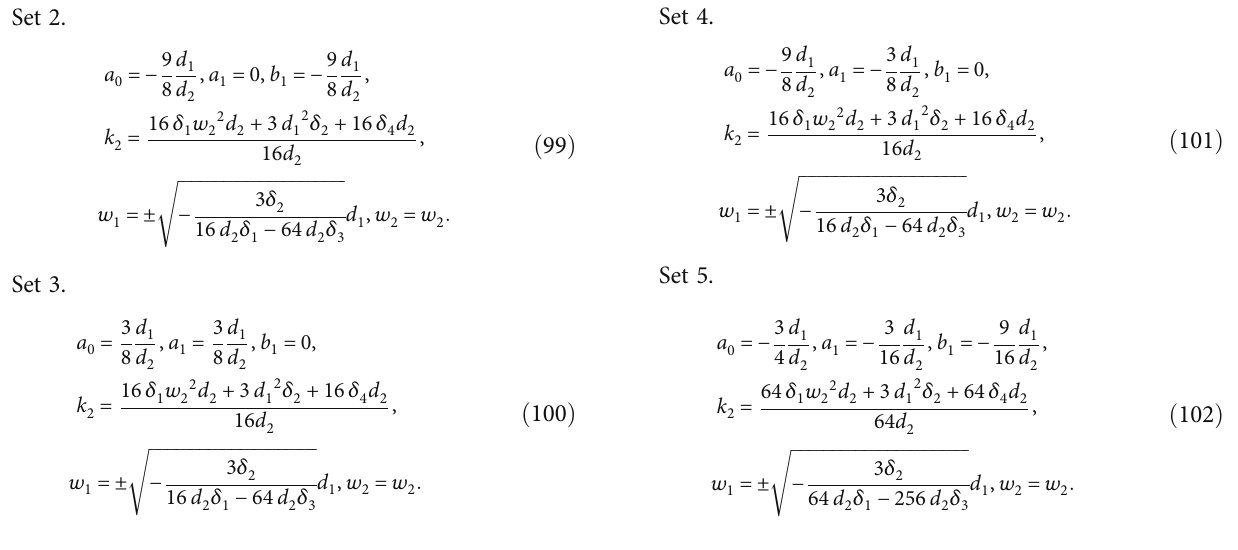
ð x , t Þj for NLFD of order α and for parameters δ 2